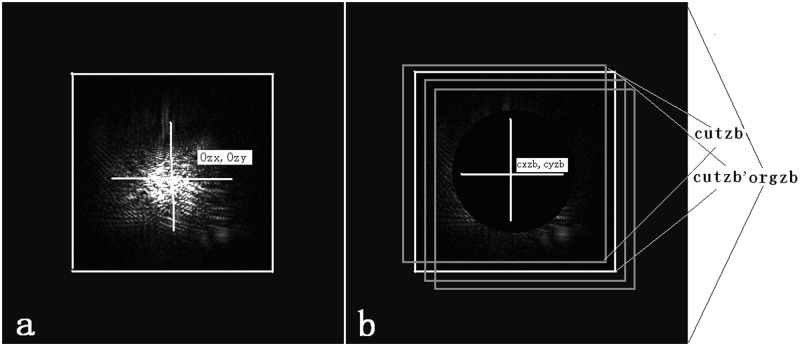
Calculation of the correlation between cutzb and cutpb.(a) The clipped region of the second clipped main lobe image in cutzb. (b) Identification of the best matching position, for which the correlation coefficient between the side lobe image and the main lobe image with a circle dug is maximal.